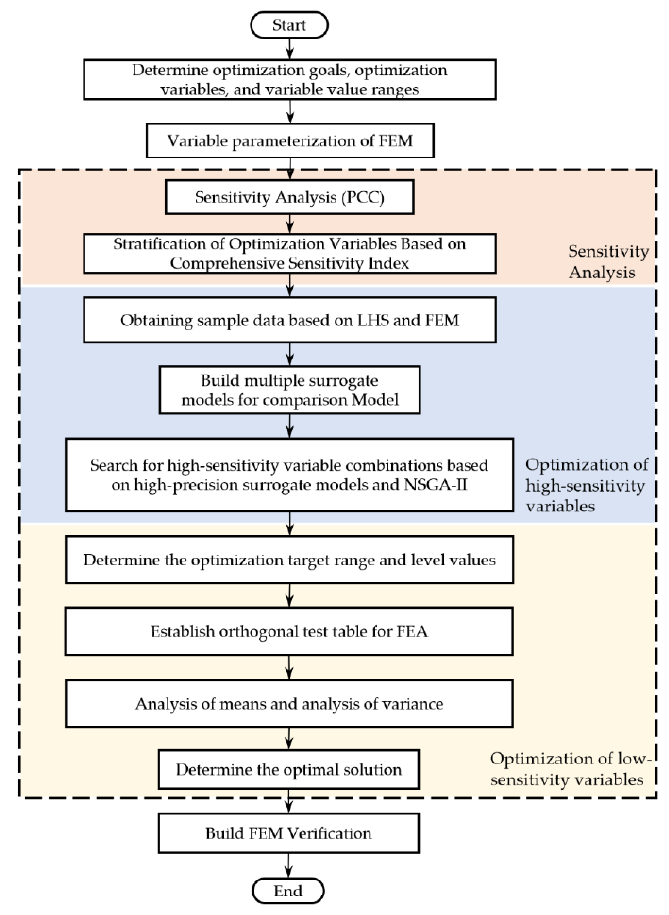
Figure 2. Flowchart of multi-objectives optimization method.